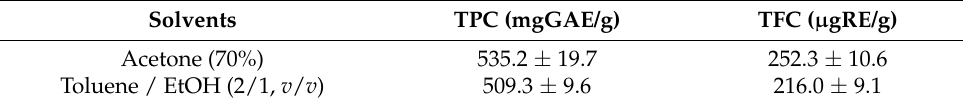
Figure 1. Yields of heartwood extractives from A. confusa soaked in acetone and toluene/ethanol solvents using different extraction times (based on the dry weight of heartwood). Table 1. Total phenolic contents (TPC) and total flavonoid contents (TFC) of heartwood extractives from A. confusa.